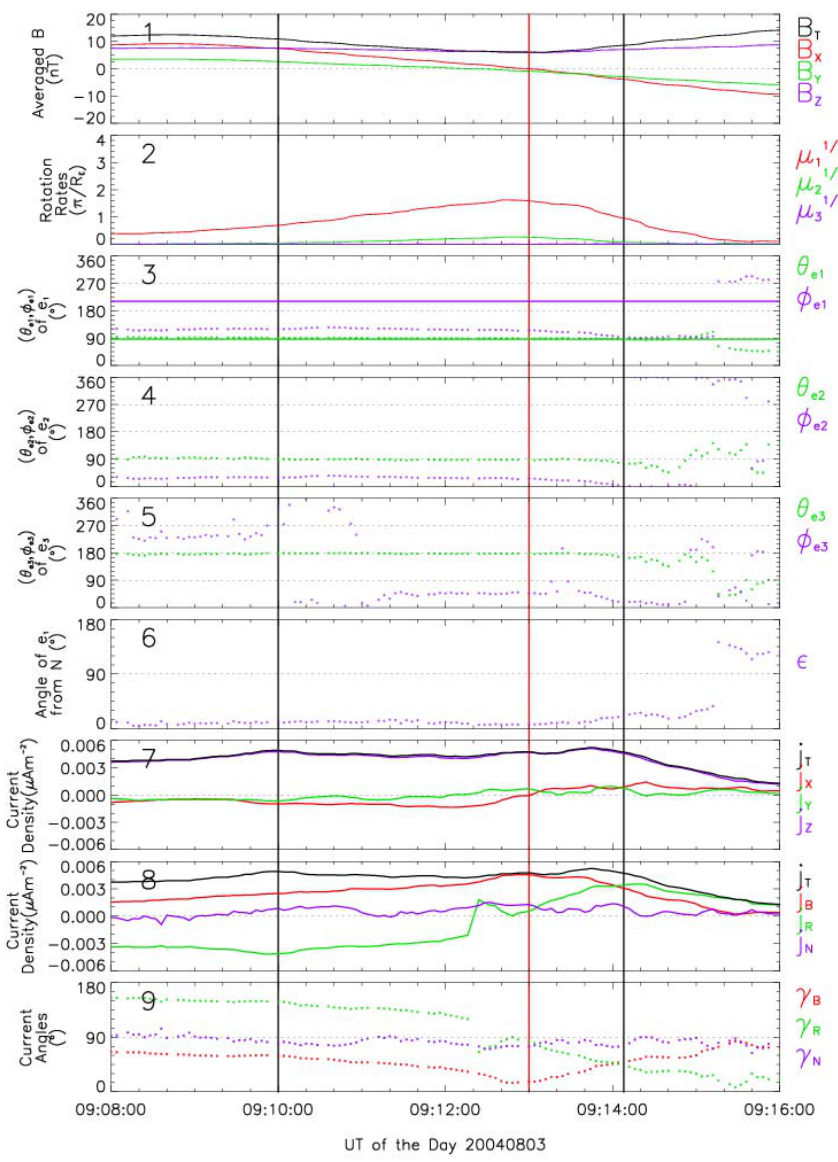
Fig. 3b. The geometric structure of the tilted current sheet during one Cluster crossing event on 3 August 2004. The format of the figure is the same as Fig. 1b.